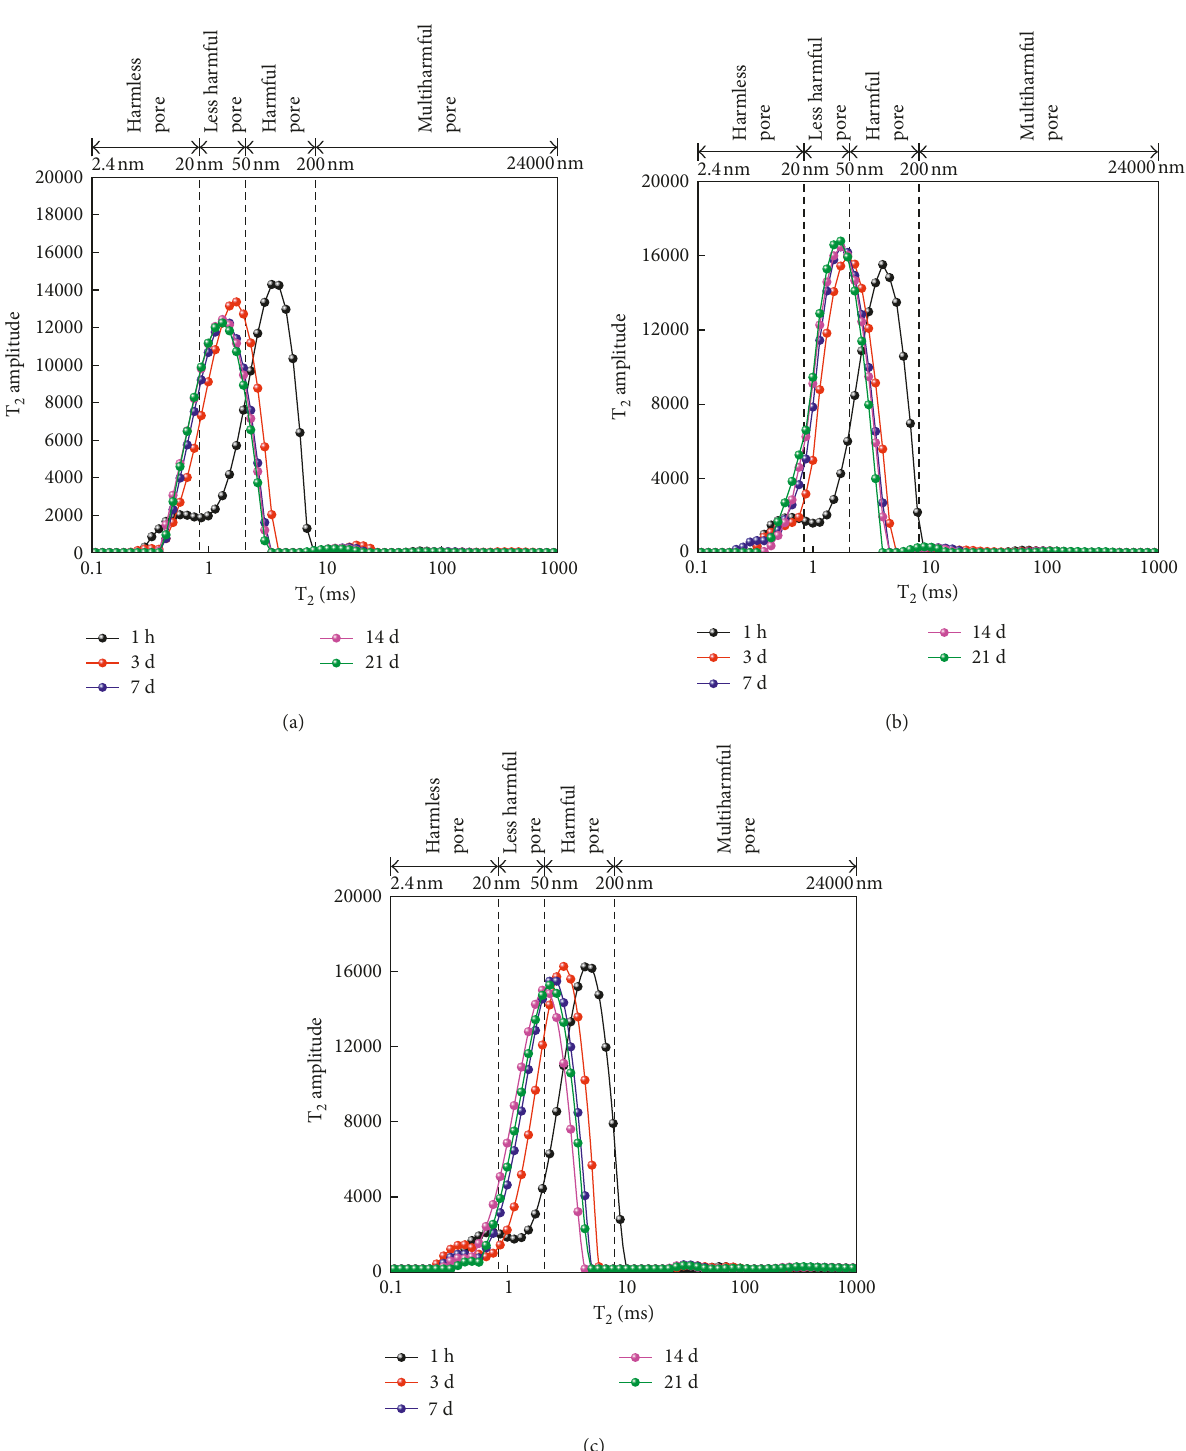
Figure 6: T 2 curves and pore size distributions of the filling slurries with different cement-sand ratios: (a) 1 :3, (b) 1 :5, and (c) 1: gradually flattened after 3 d. However, the changes in the filling slurries with cement-sand ratios of 1 : 5 and 1 : 8 were small after 7 d, which indicates that the delay time of the filling slurry hydration reaction increased as the cement- sand ratio decreased.